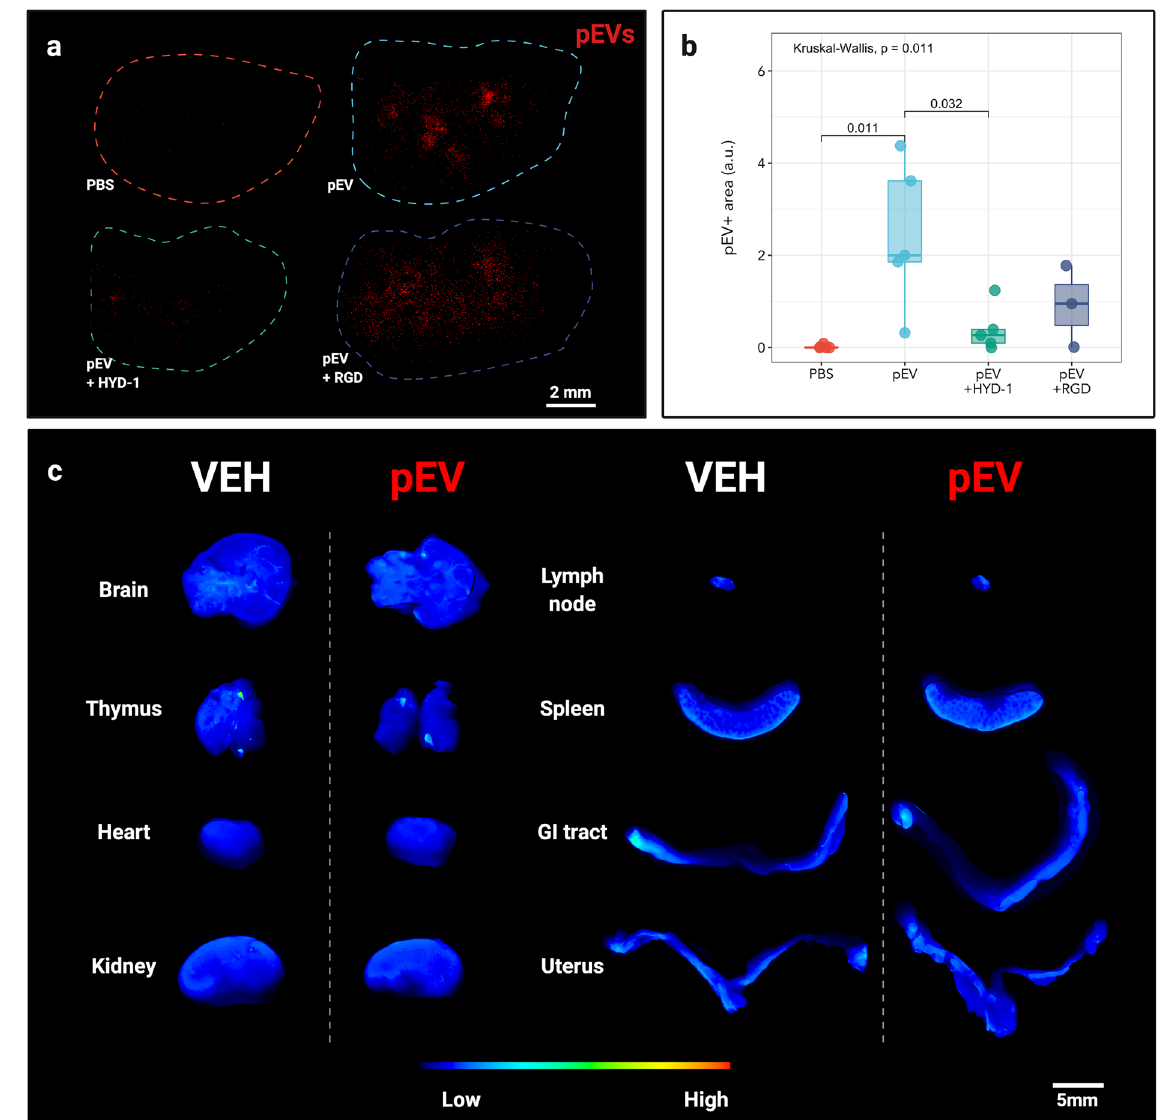
Figure 5. Integrin α3β1 mediates placental EV trafficking to the lung. ( a ) Representative near-infrared image of whole lung after in vivo treatment with labeled placental EVs after 24 h. Image is representative of three independent experiments. ( b ) Quantification of NIR placental EV positive area from whole lung treated with placental EVs. a.u., arbitrary units. Each point represents one biological replicate; n = 3–7 animals per treatment. ( c ) Representative whole organ NIR imaging of mice treated with control medium (VEH) or placental EVs (pEV) after 24 h. Representative of three independent experiments using five total animals (n =